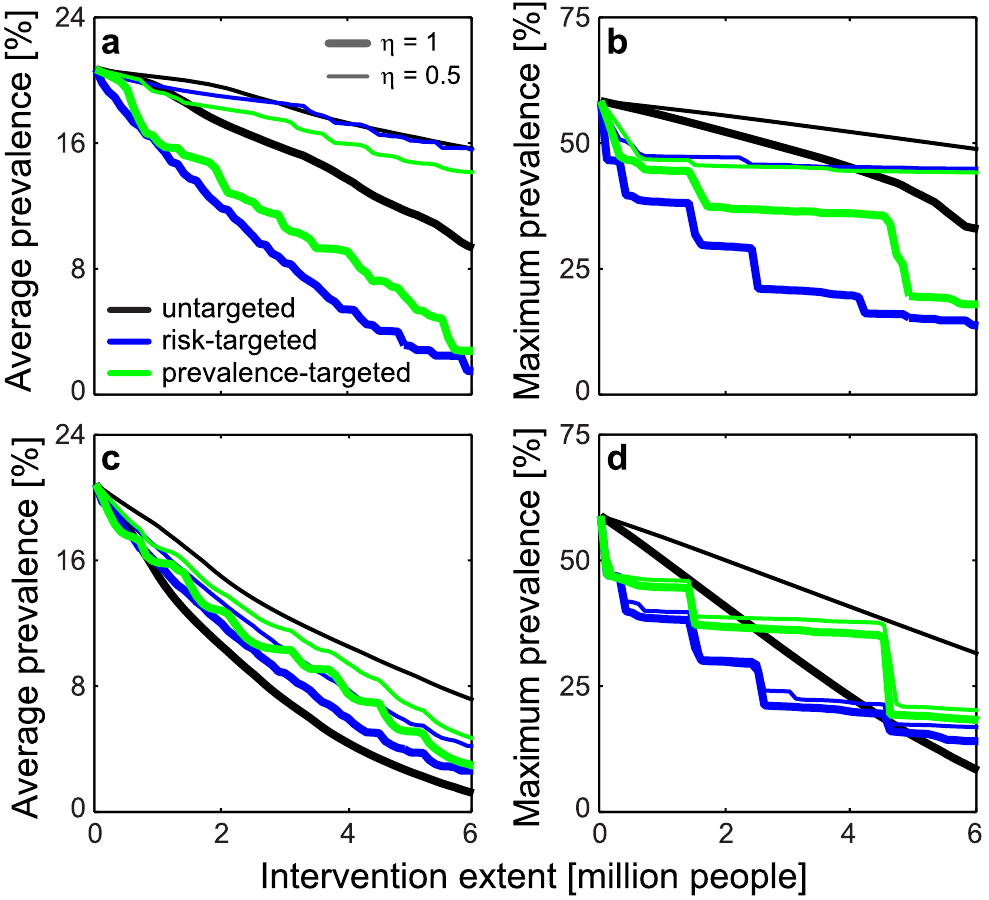
Figure 4. Evaluation of large-scale control strategies. ( a ) Effect of WASH interventions on country-wide average schistosomiasis prevalence. ( b ) As in panel a, but for maximum regional prevalence. ( c , d ) As in panels a,b, but for IEC campaigns. Targeted actions prioritize communities where transmission risk (as quantified by the quantity ρ i ω i , see Table 1 and Methods ; blue lines) or schistosomiasis prevalence (green) is highest. Results are shown for two different values of the expected efficiency ( η ) of the control actions. See SI for details on WASH/IEC interventions. Parameters as in Fig.